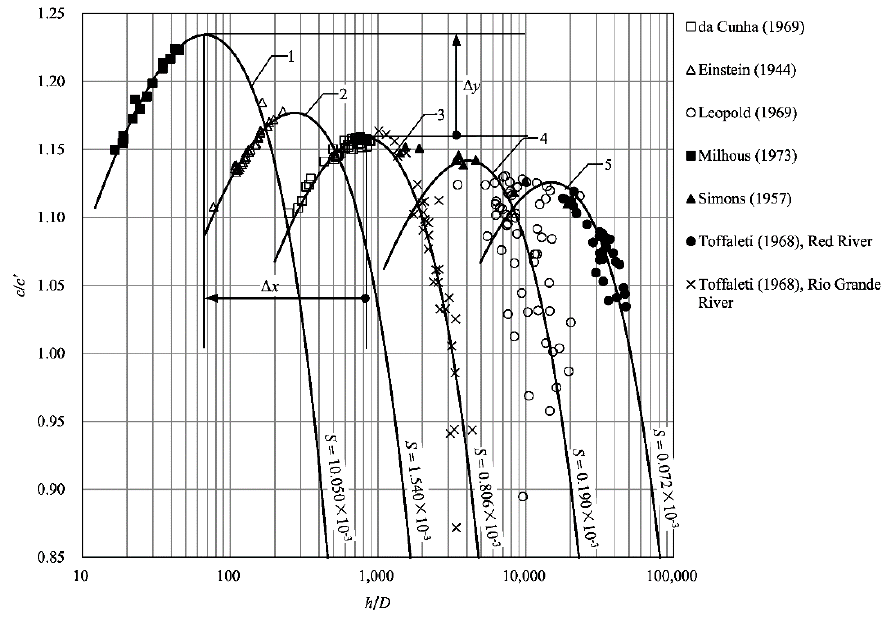
Figure 8. The relation of the resistance factor ratio c / c ’ to the relative depth h / D .